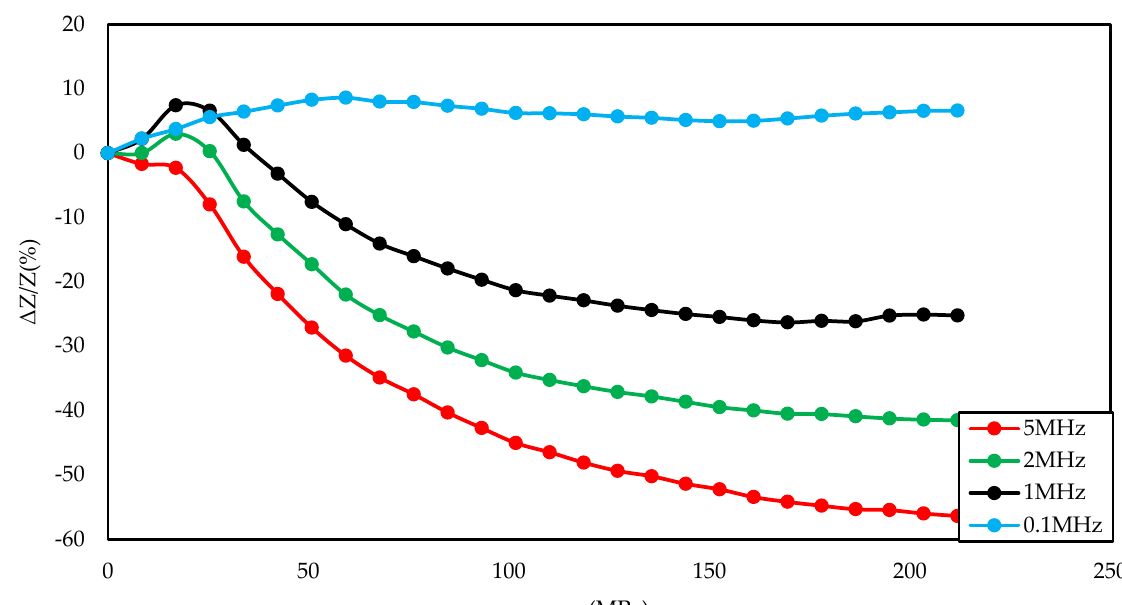
Figure 9. Dependence of impedance in a function of stresses for different magnetizing fields for the annealed by a 900 mA current sample.